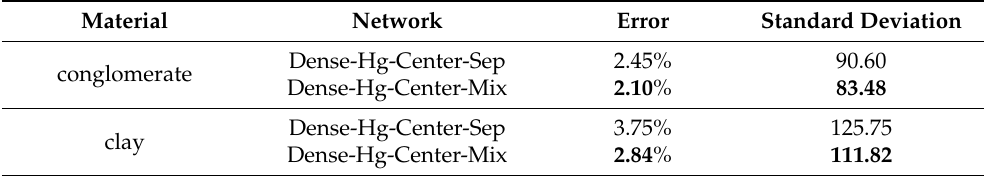
Table 3. Ablation experimental results for training strategy.